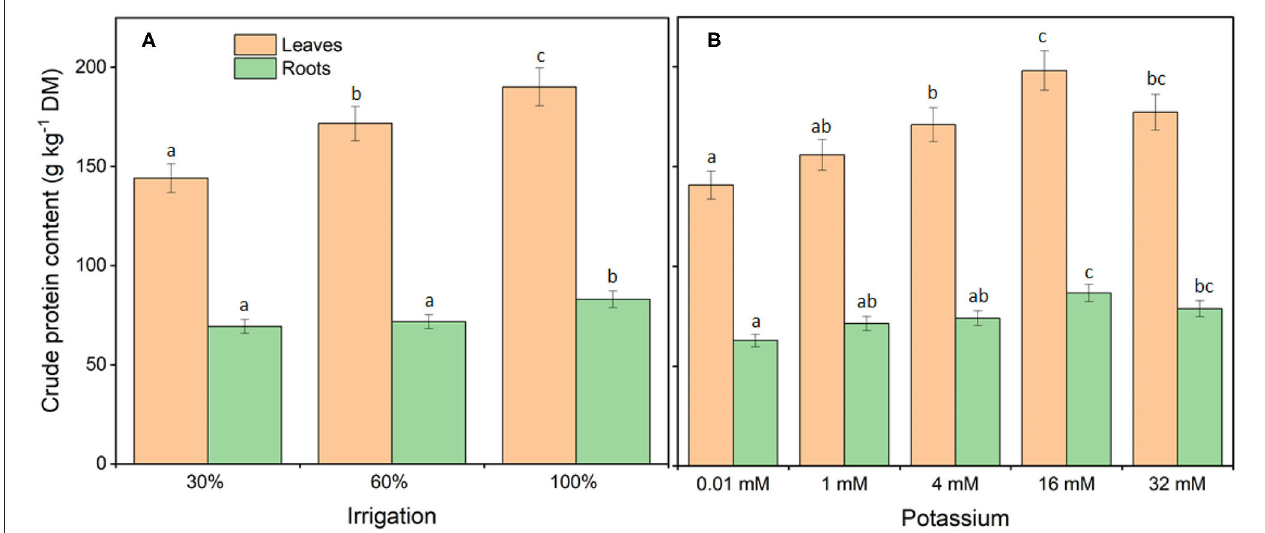
FIGURE 1 | Crude protein content of young cassava plants in response to deficit irrigation (A) and potassium fertigation (B) . Crude protein content in leaves and roots were both affected by irrigation ( P < 0.001) and K ( P < 0.001) but no treatment interactions (I × K) were observed in leaves ( P = 0.901) and roots ( P = 0.121). Treatments were initiated 30 days after planting and lasted 60 days. The data from four separate experiments were combined and shown as means ± standard errors; n = 4–16 replicate plants. Means followed by different letters in the same graph are significantly different (Tukey’s test P < 0.05).